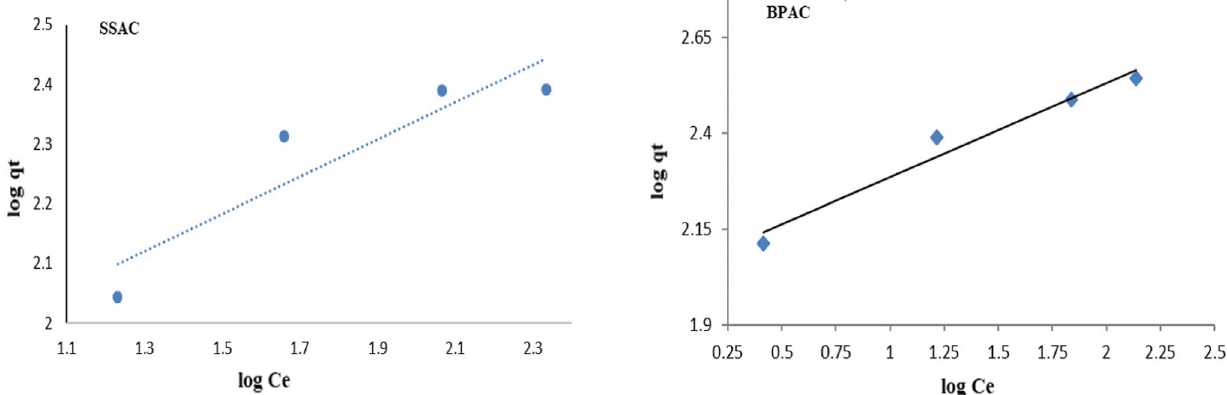
Fig. 9 Freundlich isotherm models of adsorption BB41 by PBAC and